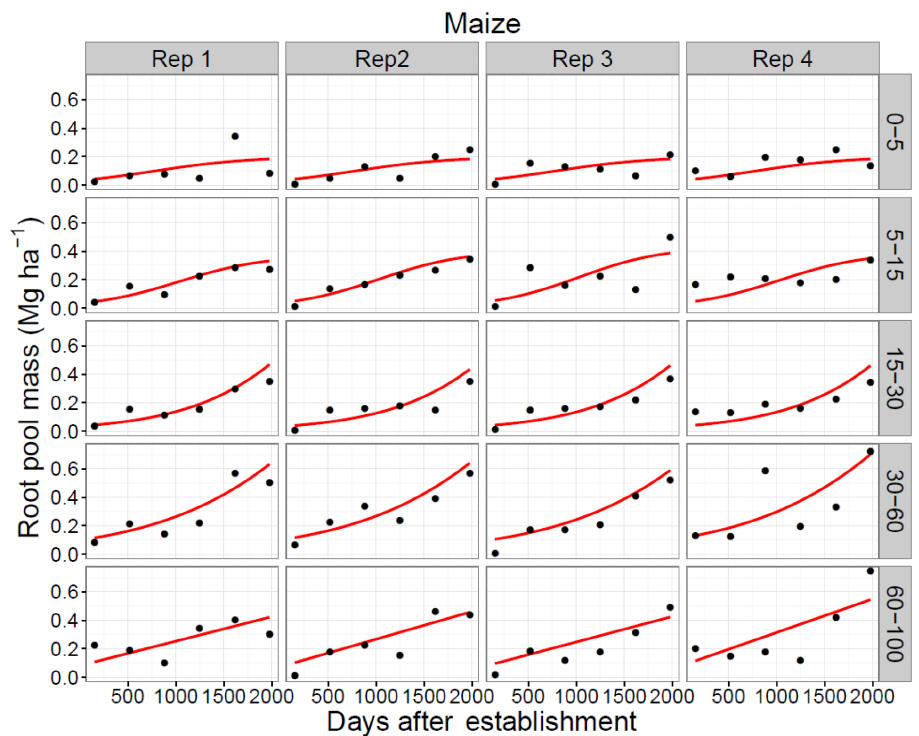
Figure A3. Logistic curves fit to root pool mass accumulation at each replication and depth increment in the maize